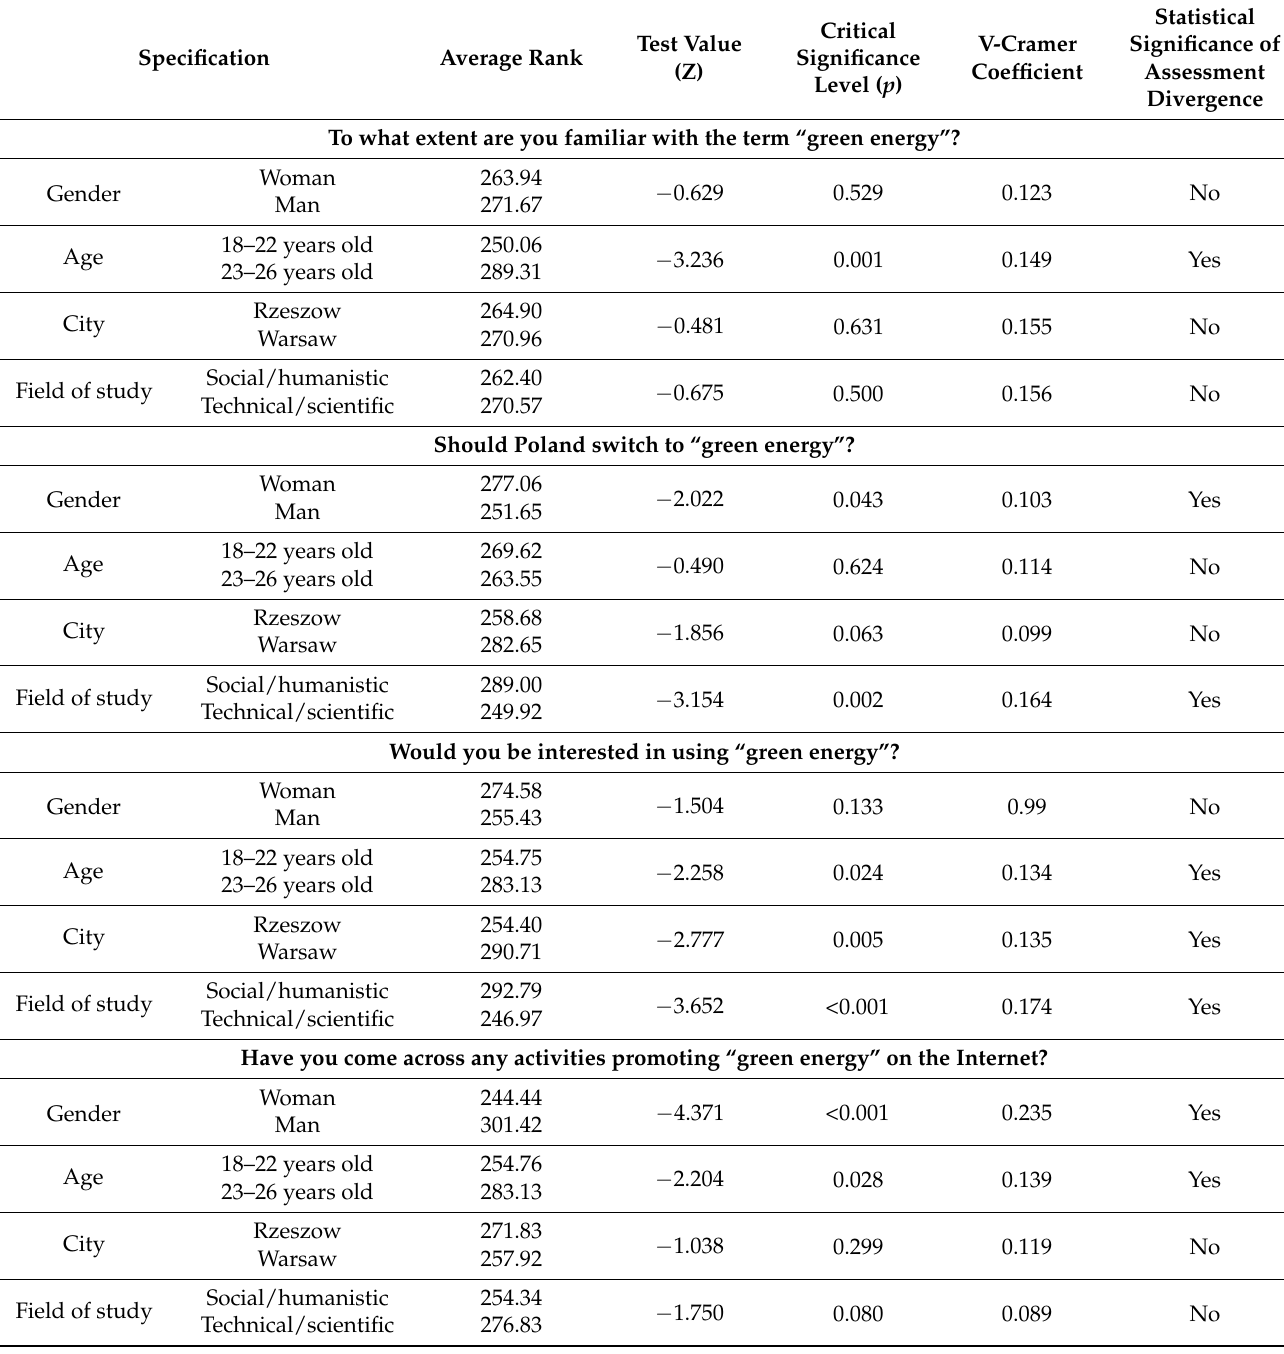
Table 8. An assessment of the relationship between the knowledge of green energy and its promotion and the variables describing the